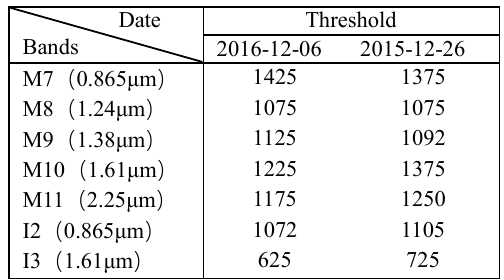
Table.2 Threshold selection for single-band threshold